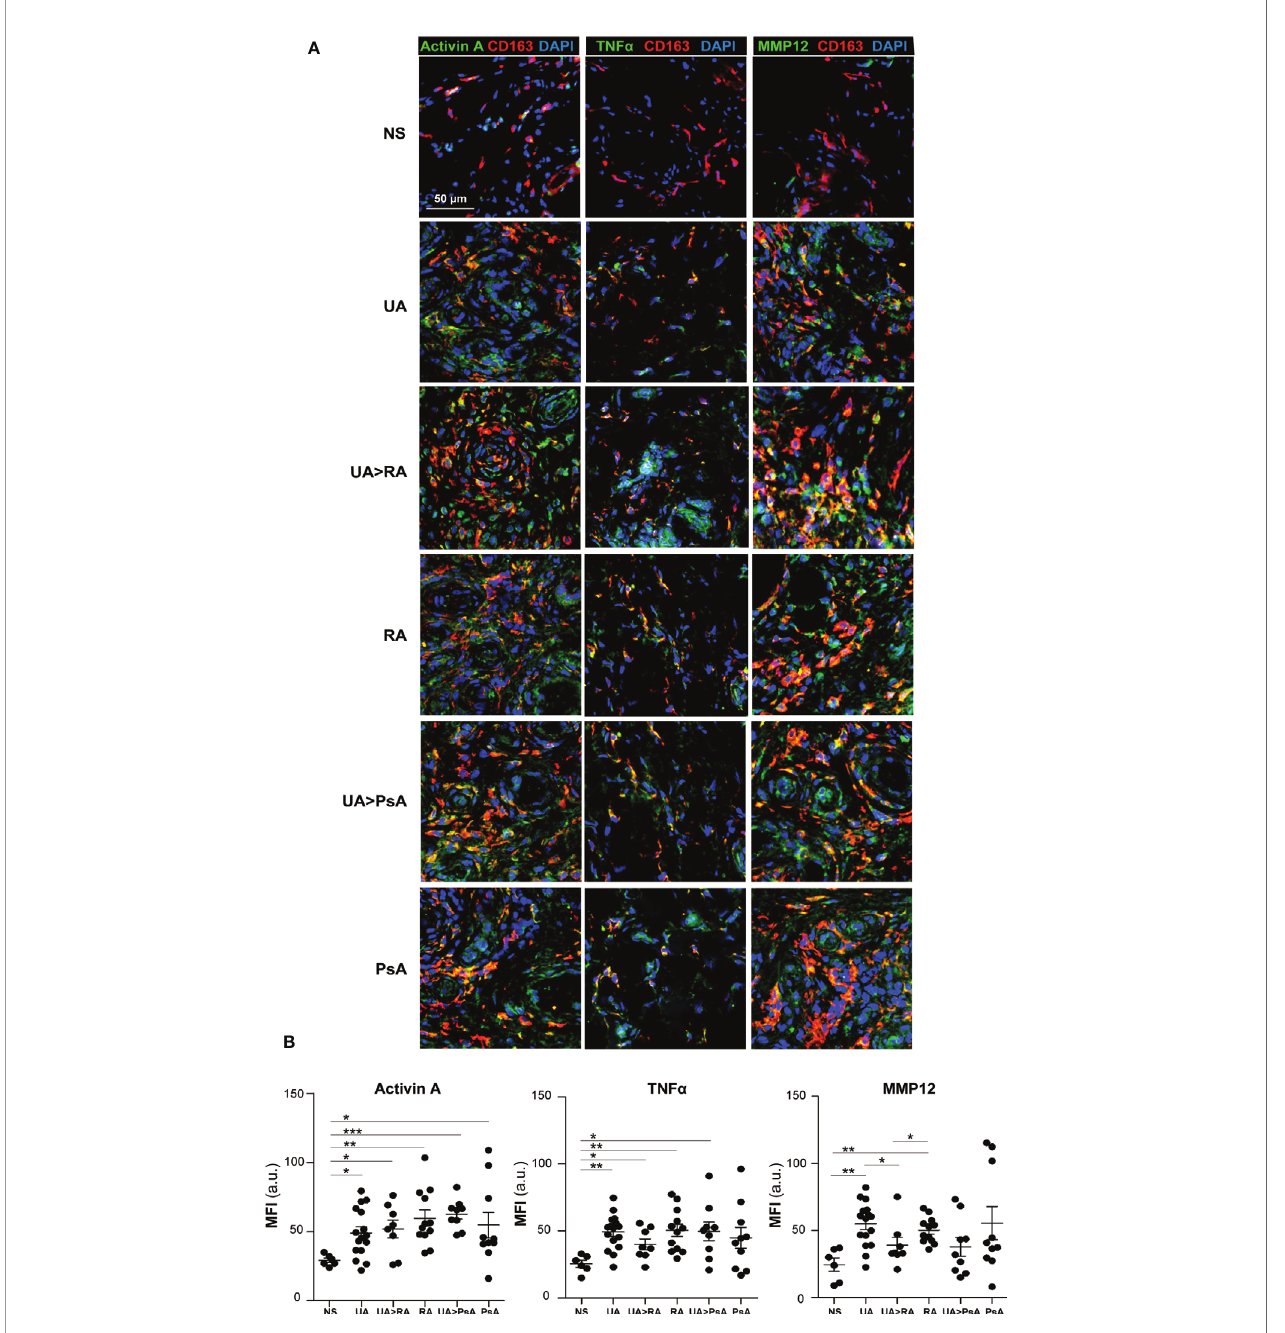
FIGURE 3 | Expression of macrophage-pro-in fl ammatory polarization markers by CD163 + macrophages from undifferentiated arthritis patients. (A) Immuno fl uorescence analysis of synovial tissues as determined by confocal microscopy using anti-activin A, TNF a -, MMP12-speci fi c antibodies; nuclei were counterstained with DAPI. Samples were devoid of staining when incubated with isotype-matched irrelevant antibodies as negative controls. The experiment was carried out in independent samples from each type (NS, n=6; UA, n=16; UA>RA, n=8; RA, n=12; UA>PsA, n=9; and PsA, n=10) and representative experiments are shown. Scale bars, 50 µm. (B) Summary dot plot showing mean MFI values of activin A, TNF- a and MMP12 expression in CD163 + macrophages from NS, UA, UA>RA, RA, UA>PsA, and PsA synovial tissues samples. Mean ± SEM are shown (* p < 0.05, ** p < 0.01, *** p < 0.001, Mann-Whitney